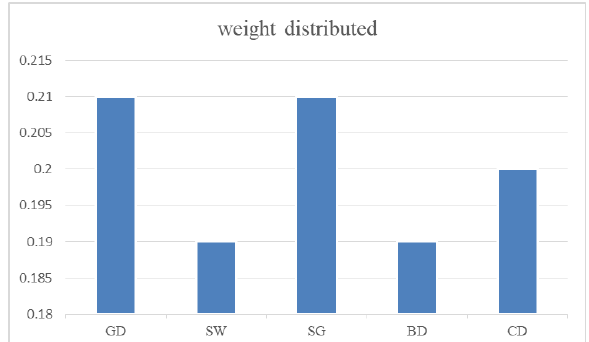
Figure 3 . Reference data weight distribution diagram